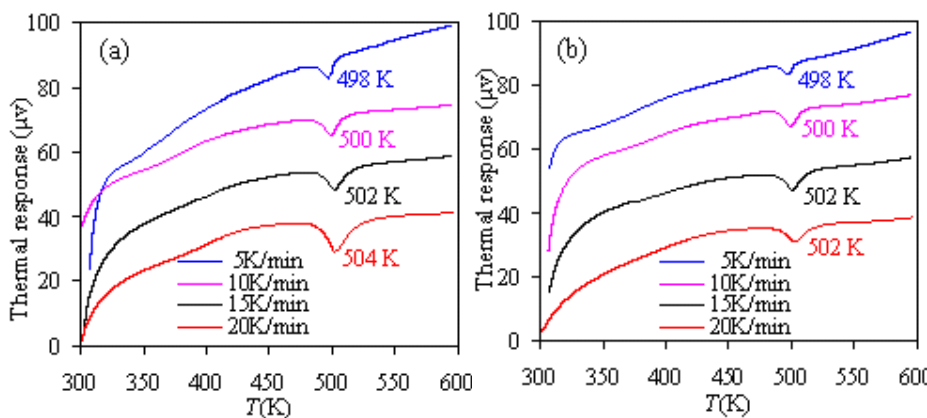
Figure 4. DTA results of nylon-6 tennis string waste measured in N 2 ( a ) and air ( b ).